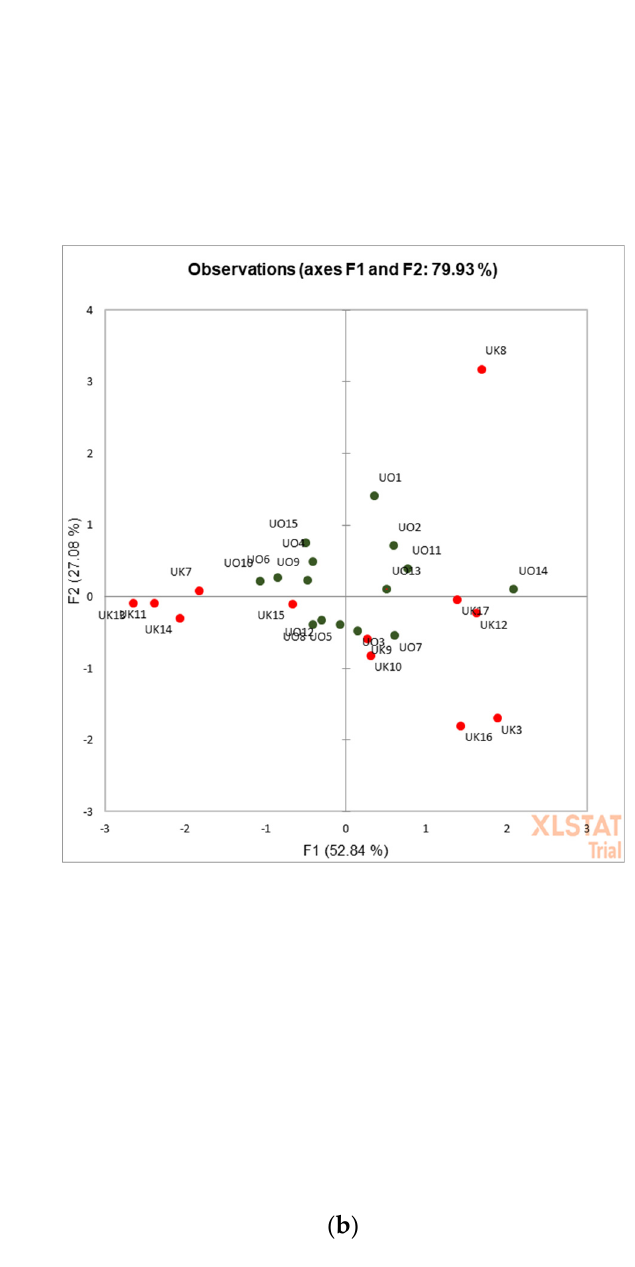
Figure 4. Comparison of the analyte content in the matched pairs of commercial beers ( a ); PCA graph of commercial beer samples with analytes contents as variables ( b ).